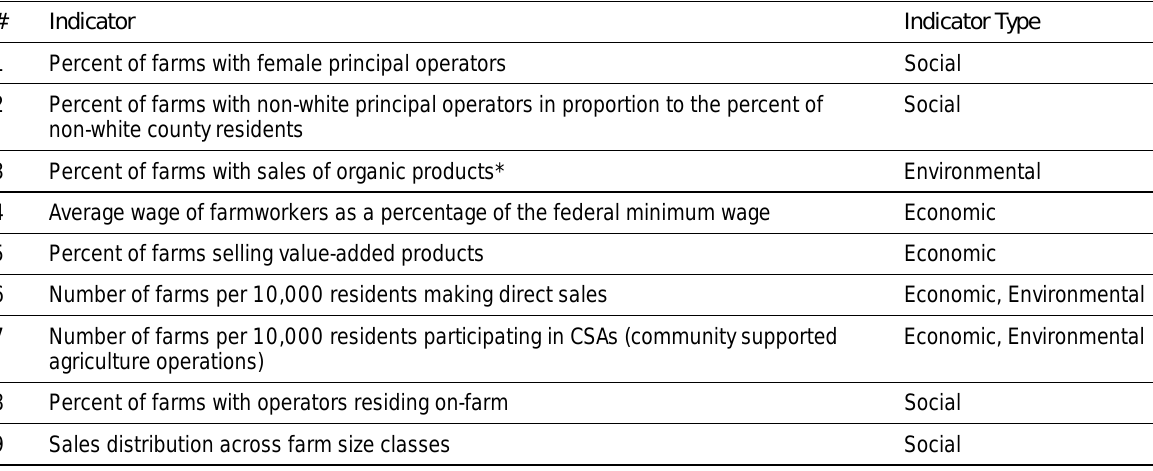
Table 1. Progressive Agriculture Index Classification of